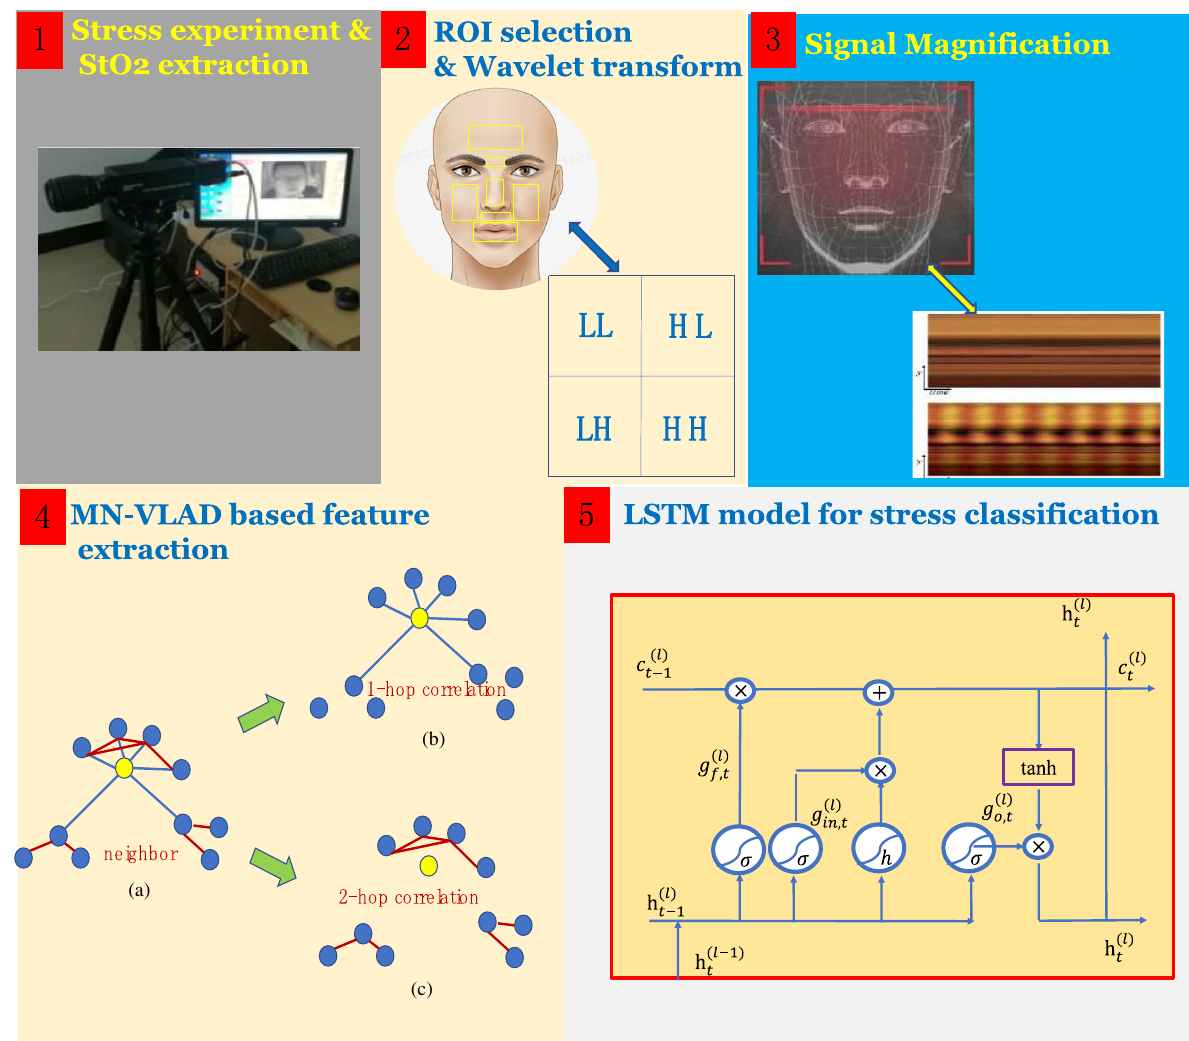
Figure 2. Process of SC-Net. The whole process starts from the experiment. After obtaining the StO2 signal, we extract the relevant signal of interest through ROI selection. Then, features are extracted by signal amplification and MN-VLAD based model. Finally, all features are put into LSTM model to complete stress